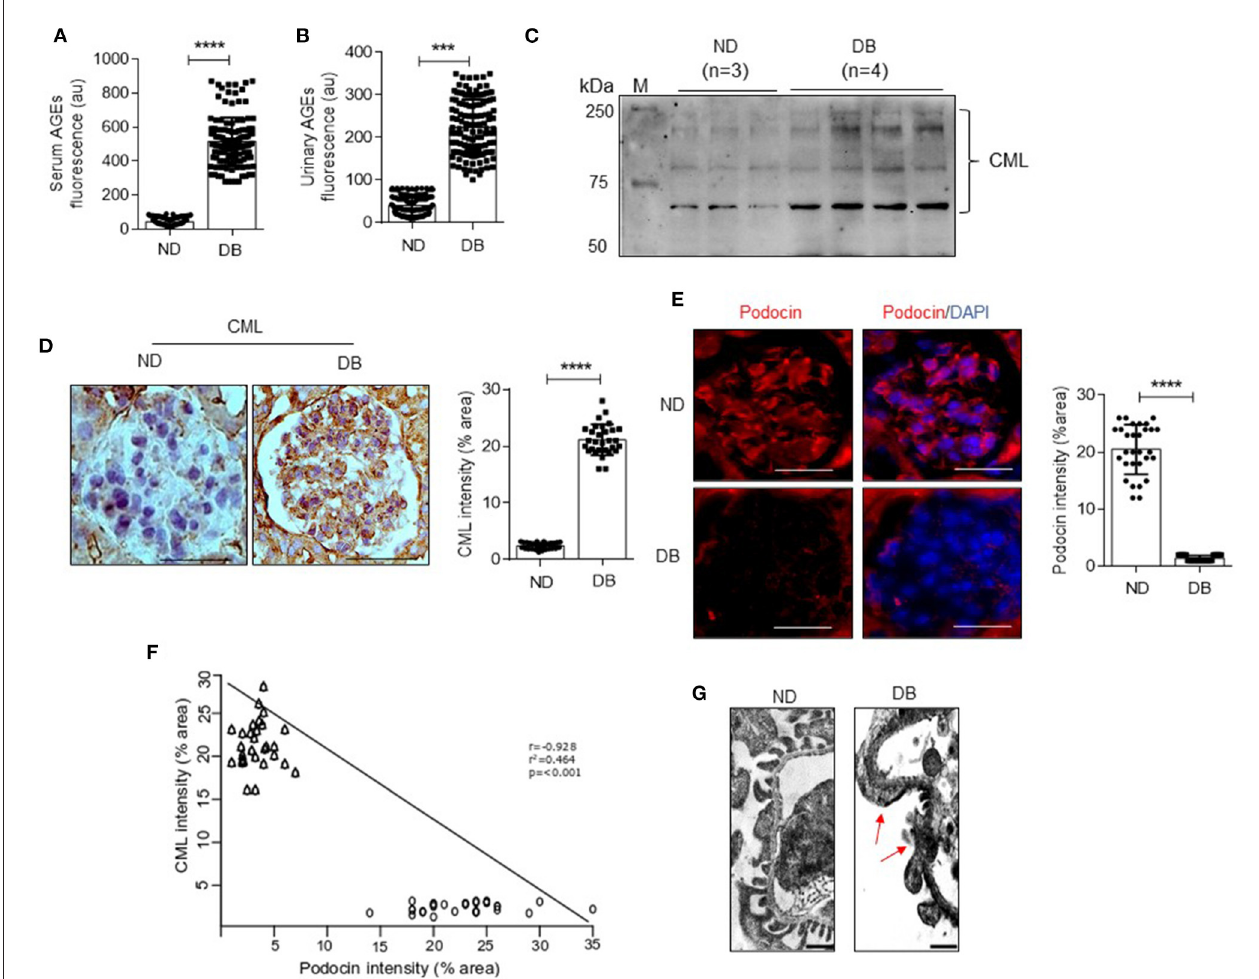
FIGURE 2 | Fluorometric assessment of serum (A) and urinary (B) AGEs in ND and DB both the groups ( n = 130) (Ex: 370nm; Em: 440nm). *** p < 0.002 and **** p < 0.0001. (C) Immunoblotting analysis of CML in serum samples from ND and DB groups. M = standard protein marker. (D) Immunohistochemical analysis of CML in the glomerulus of kidney biopsy samples from ND and DB groups (Left). Magnification (x 630). Scale bar = 20 µ m. The percentage of stained area per field from glomerulus was quantified and represented as a dot plot (Right). Each data point represents an average value of 6 glomeruli from ND and DB both the groups. **** P < 0.0001. (E) Immunohistochemical staining for podocin in the glomerulus of ND and DB kidney biopsy samples (Left). Magnification (x 630). Scale bar = 20 µ m. The percentage of stained area per field from glomerulus was quantified and represented as a dot plot (Right panel). Each data point represents the average value of 6 glomeruli from ND and DB both the groups. **** P < 0.0001. The intensity of glomerular expression of CML and podocin was quantified using ImageJ. ( F ) Correlation analysis of CML vs. podocin staining intensity in the glomerulus of ND and DB groups. Correlation is significant at the 0.001 level (2-tailed). ( G ) TEM images of podocytes from ND and DB kidney biopsy samples. The arrow indicates foot process effacement. Scale bars indicate 0.5 µ